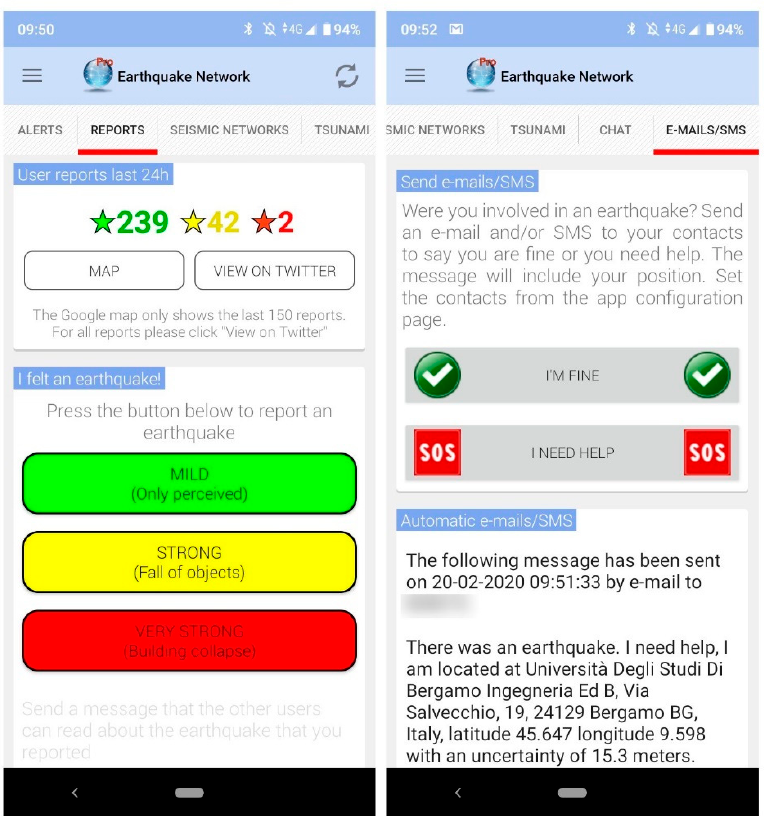
Figure 10. User interface of the Earthquake Network app for sending felt reports ( Left ) and for asking for help if involved in an earthquake ( Right ). Source: [37]. Figure 3, page 5.